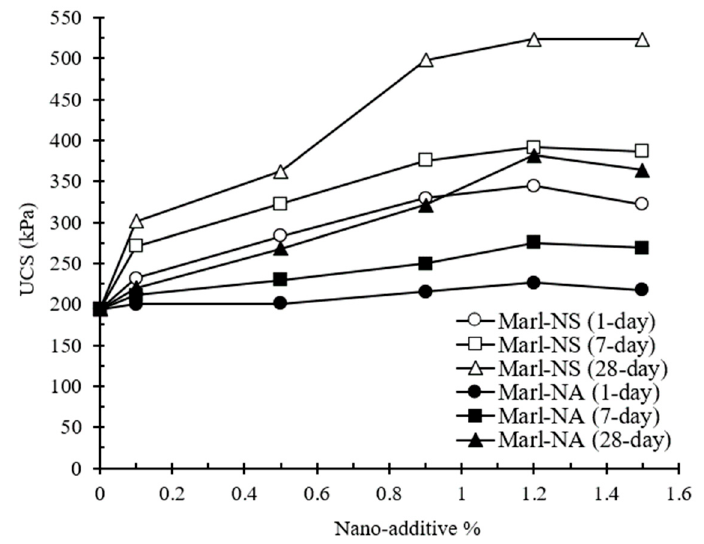
Figure 2. UCS of nano-additive treated marl.